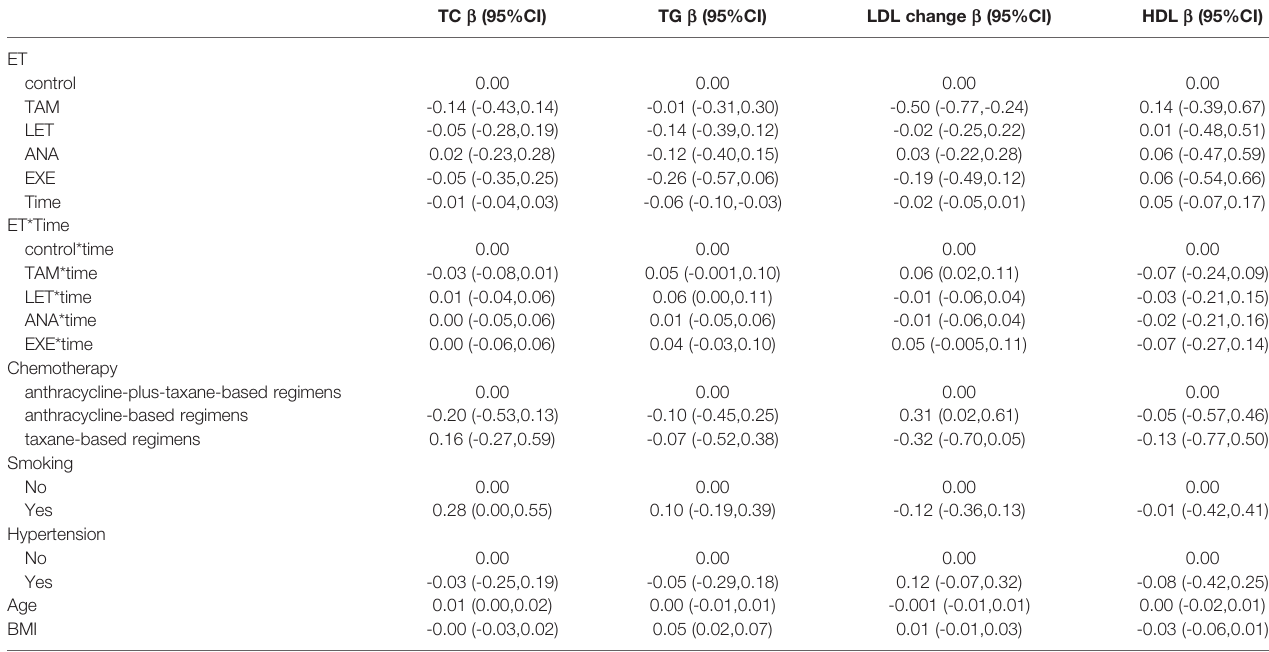
TABLE 4 | Comparison of lipid pro fi les in postmenopausal BC patients.